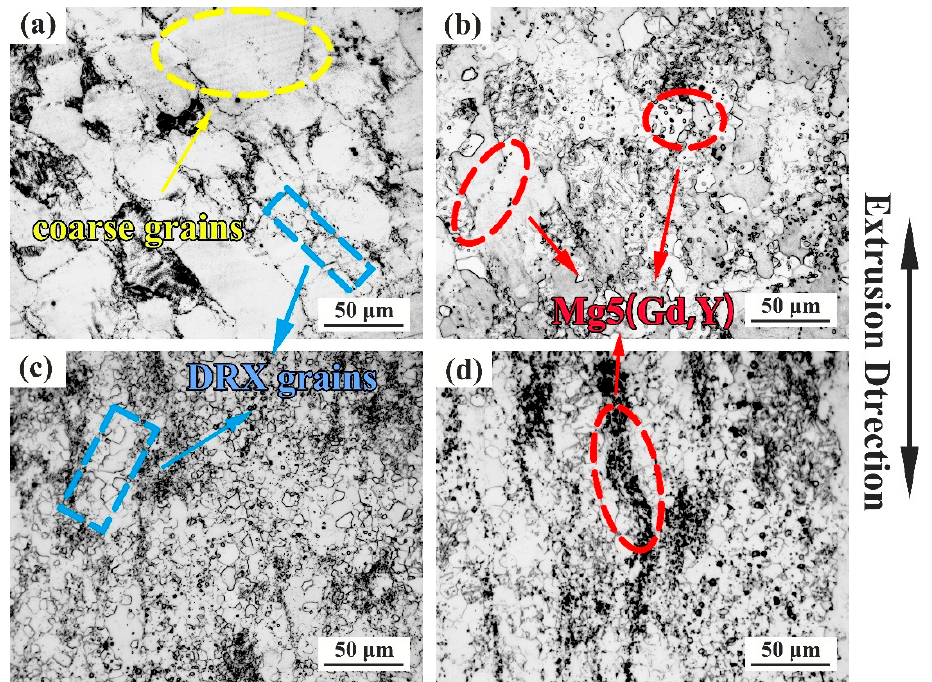
Figure 3. The OM microstructure of the samples RUEed after different passes. ( a ) 1 pass; ( b ) 2 passes; ( c ) 3 passes; ( d ) 4 passes.